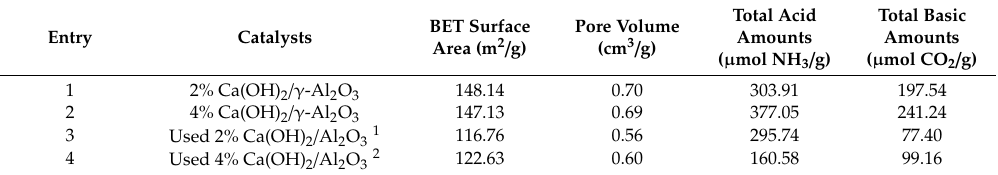
Table 6. Typical properties of